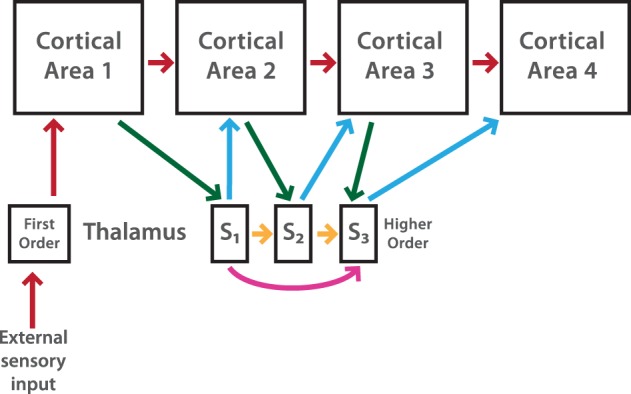
Schematic diagrams showing organizational features of cortico-thalamic-cortical (CTC) loops. First order (FO) nuclei (e.g., LGN) receive drive input from sensory cells. A FO nucleus represents the first relay from the thalamus to the primary cortical area. The CTC pathway includes the cortico-cortical (CC) pathway, in this case only feedforward connections (red arrows), but it also takes into account non-reciprocal connections from a higher order (HO) thalamic nucleus (e.g., the Pulvinar). To create a non-reciprocal loop between cortex and thalamus, cortical neurons in layer ℓ receive input from thalamic subdivision ℓ−1, while this subdivision sends input to neurons in cortical area ℓ. The transthalamic pathway (green and blue arrows) assumes that the activity flow passes from one cortical area to another area through the HO thalamic nucleus. This is possible by long-range connections inside the thalamus (magenta arrows). For simplicity only one thalamic subdivision (S3) shows these connections. Thalamic HO neurons in subdivision ℓ receive inputs from neurons in subdivision ℓ −1 and also from neurons in subdivisions 1, 2,…, ℓ − 2. A feedforward pathway through thalamic subdivisions is also considered (orange arrows). These connections are assumed in our cortex-thalamus network. Redrawn after Hegde and Felleman (2007).